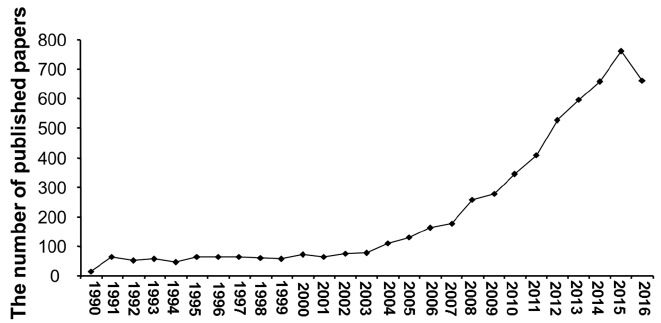
Figure 1. The number of H 2 SBM research publications between 1990 and 2016.